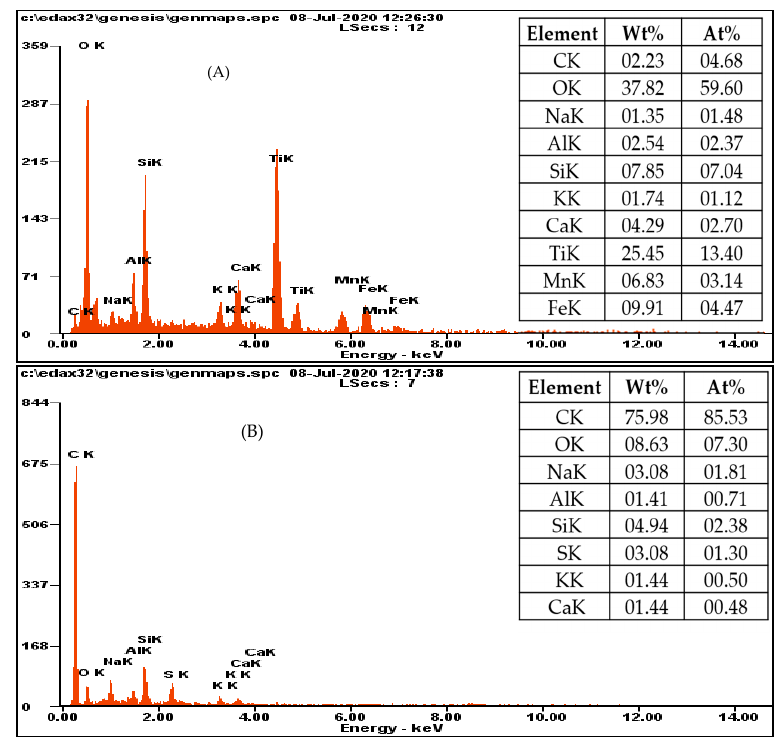
Figure 3. EDX profiles of ( A ) welding wastes and ( B ) GO.